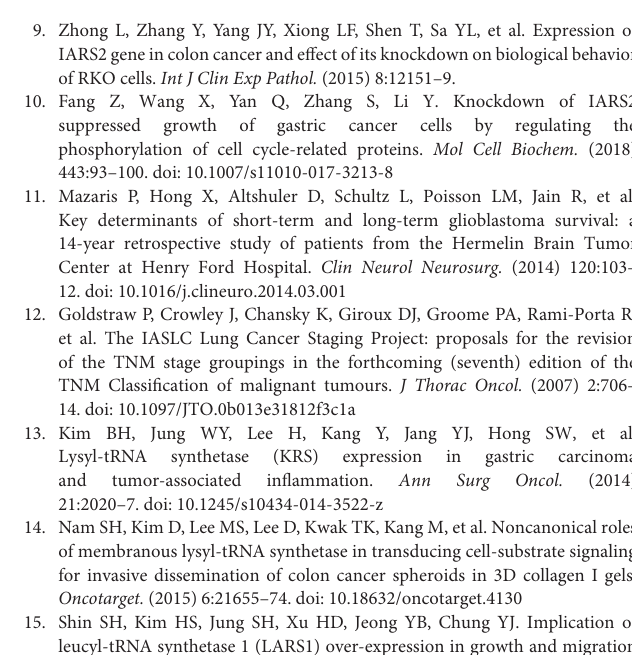
Figure S1 | Effect of silencing IARS2 on